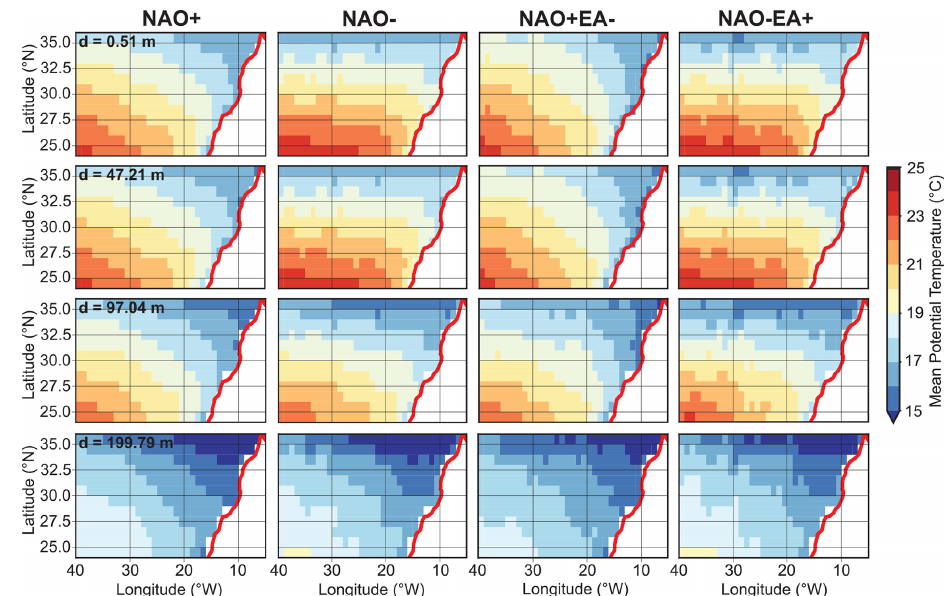
Figure 7. Composite maps of temperature for positive and negative NAO and opposite NAO and EA phases showing the spatial extent of upwelling at different depths; red line represents the coastline. For NAO + , 48 months (12 winter means) where used; for NAO − , 8 months (2 winter means) were used; for NAO + EA − , 8 months (2 winter means) were used; and for NAO − EA + , 4 months (1 winter mean) were used.